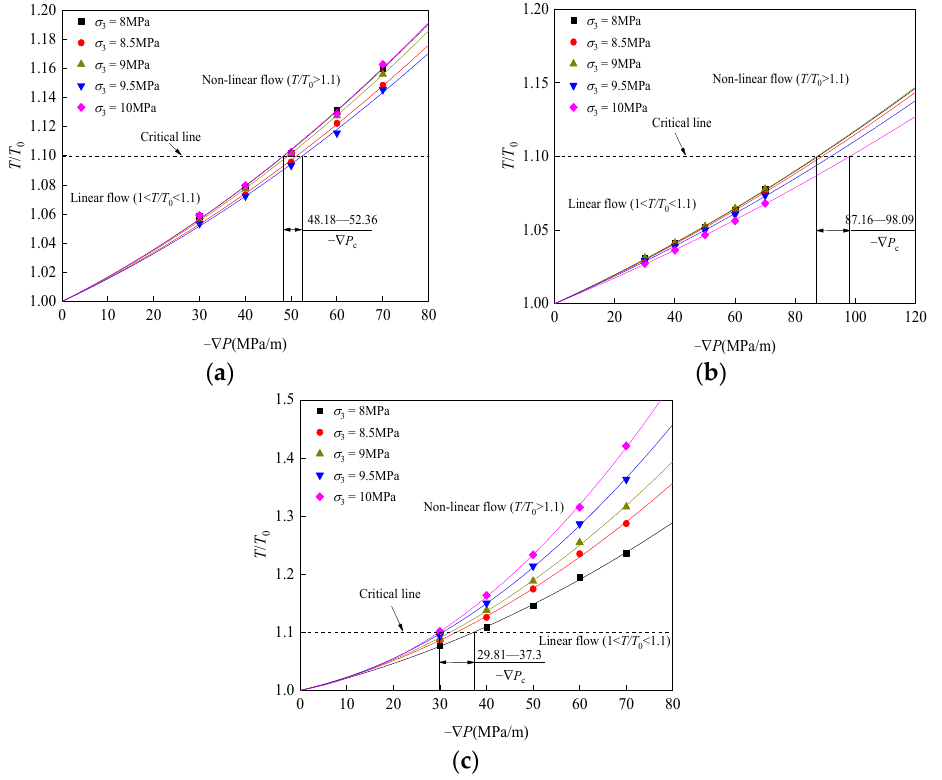
Figure 10. Evolution of normalized transmissivity T / T 0 with pressure gradient − ∇ P : ( a ) SF45; ( b ) ST45; ( c ) SY45.